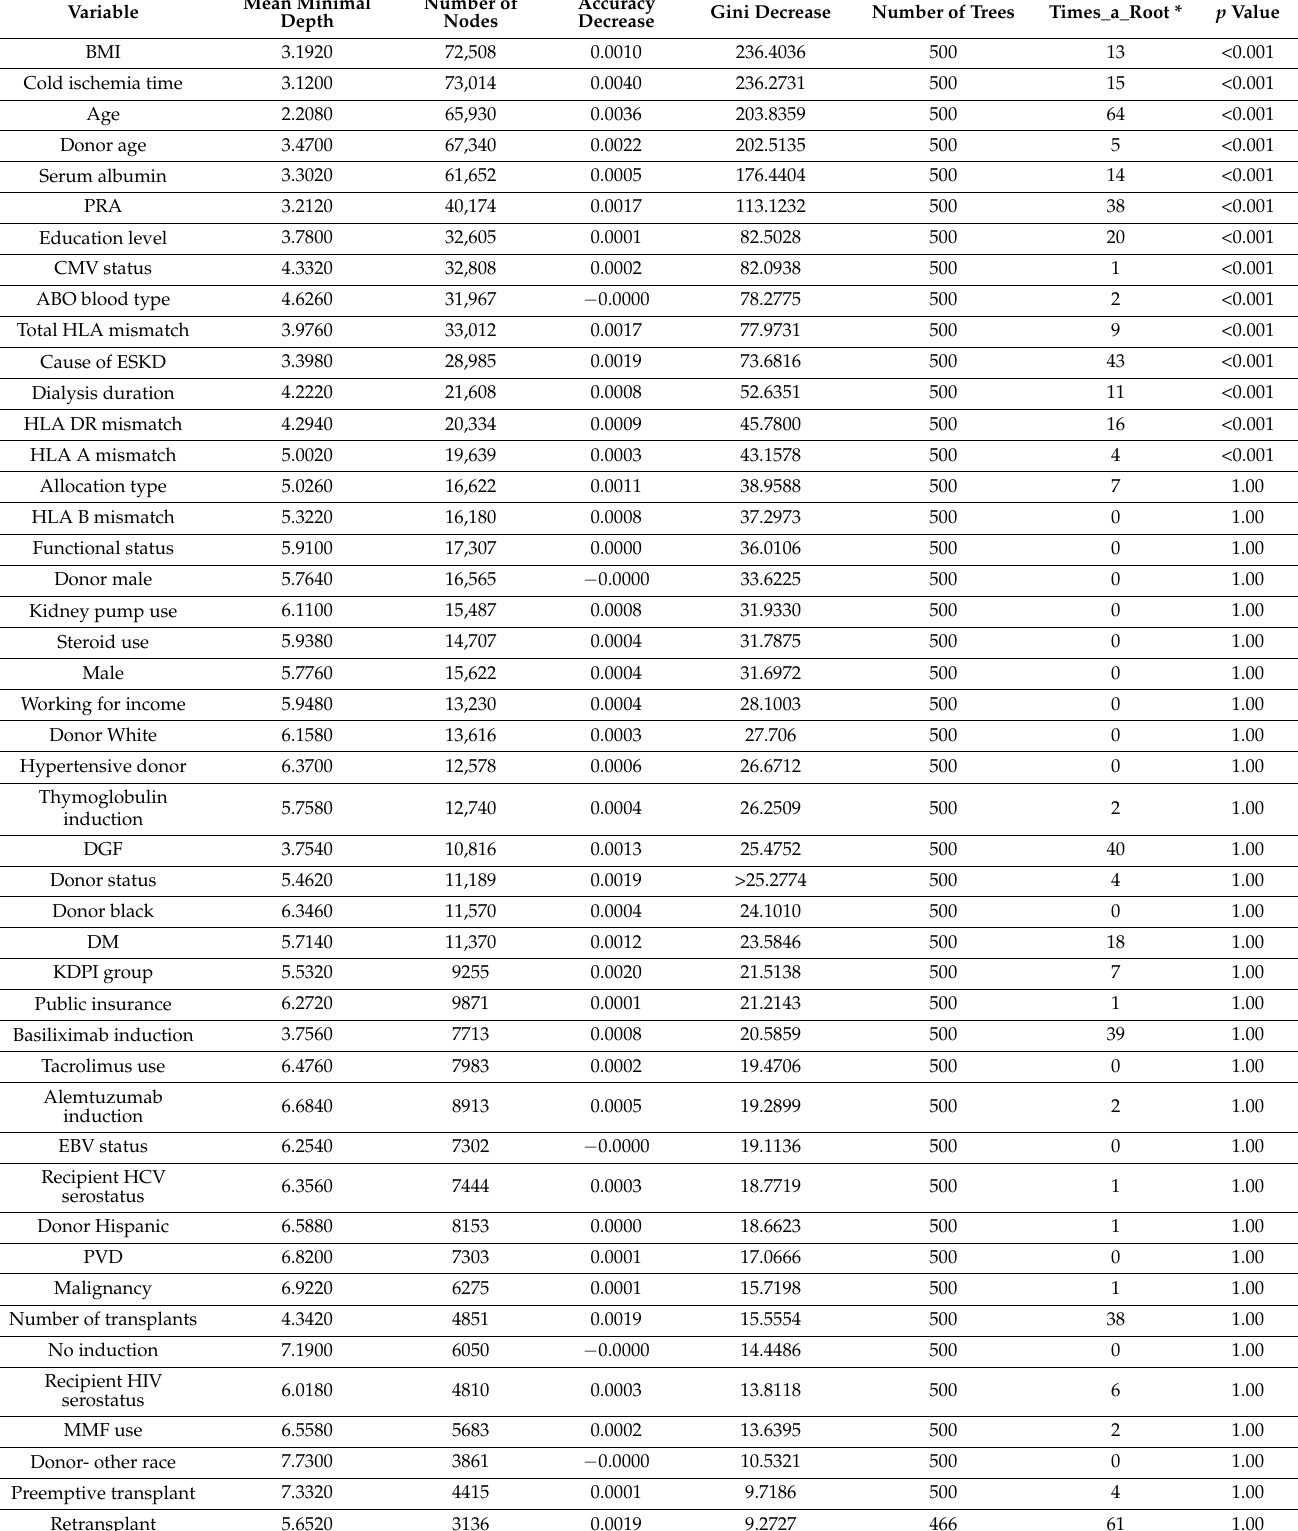
Table 3. Measures of importance for all variables in the forest (The order of these listed variables based on mean decrease in